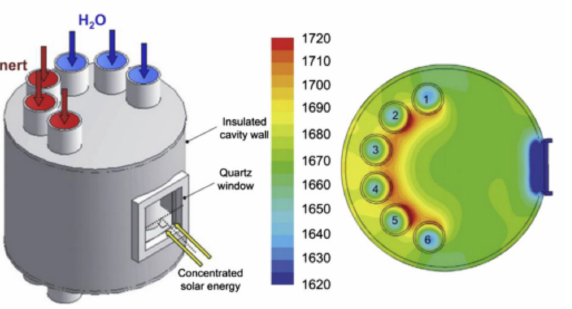
Figure 5. Isothermal reactor used for thermochemical water splitting. Reprinted from [47].